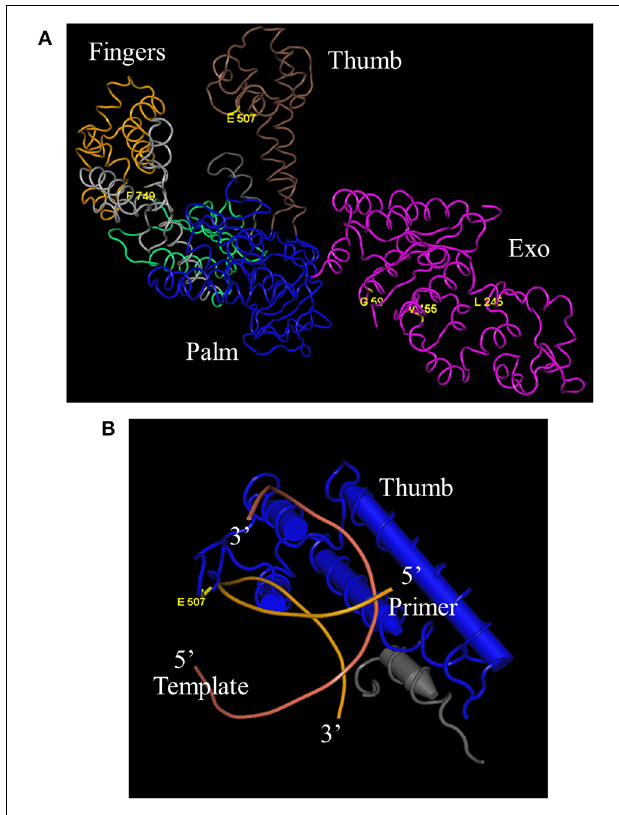
FIGURE 4 | Location of E507K and blood-resistant mutations in Taq crystal structure. “Fitness mutations” G59W, V155I, L245M, and F749I reside in the 5 (cid:2) –3 (cid:2) exonuclease and Fingers domains, respectively, while fast-cycling mutation E507K is in the thumb domain (A) (Kim et al., 1995).